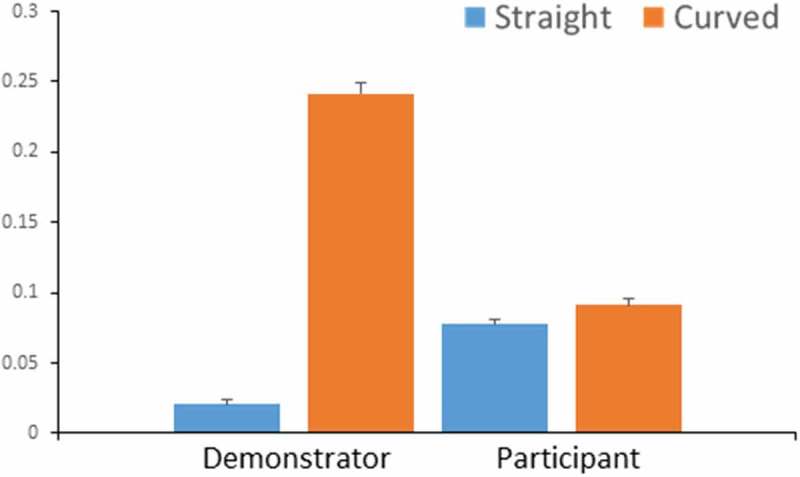
Graph comparing curvature of participants’ movements (blue) compared to the demonstrator’s (orange) in rational straight condition and in irrational curved condition. Curvature of participants’ movements was significantly different between conditions (t(17) = −2.836, p = 0.005).